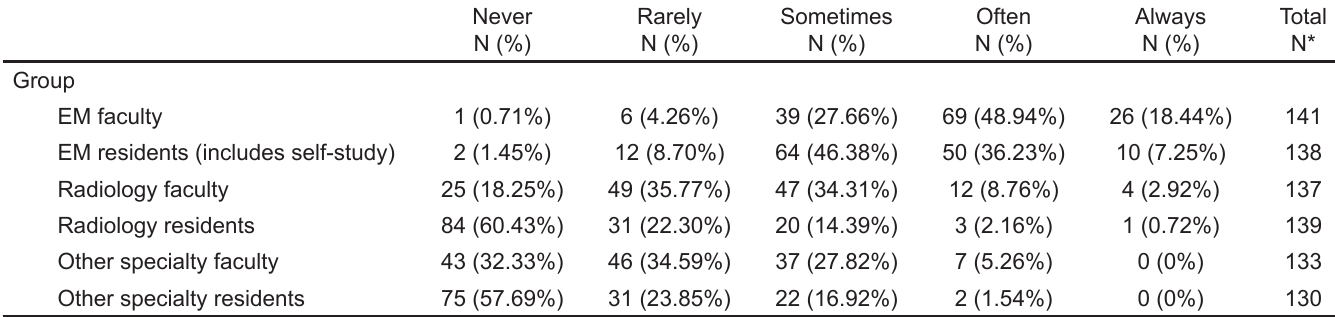
Table 2. Personnel providing radiology instruction to emergency medicine residents.